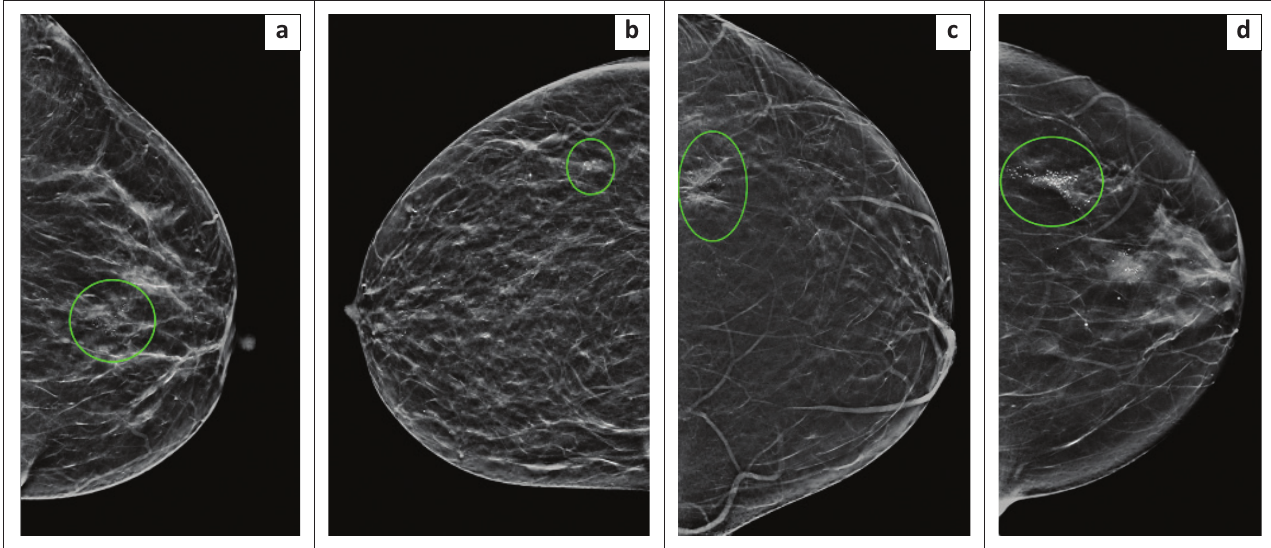
FIGURE 3: Examples of typical lesions that were suspicious for malignancy on breast imaging and confirmed malignancy on stereotactic biopsy histology. Craniocaudal views demonstrating (a) grouped pleomorphic microcalcifications in the central retroareolar region of the left breast, which showed a high-grade ductal carcinoma in situ on histology, (b) a small group of pleomorphic microcalcifications in the outer right breast, which revealed high-grade ductal carcinoma in situ on histology, (c) architectural distortion with associated grouped pleomorphic microcalcifications in the outer left breast. Histology yielded an invasive carcinoma of no specific type, (d) Two groups of suspicious microcalcifications in the left breast. The central retroareolar group of microcalcifications had a positive ultrasound correlate and was sampled by ultrasound- guided biopsy. The group of pleomorphic microcalcifications in the outer breast (circled) yielded invasive carcinoma of no specific type on stereotactic biopsy